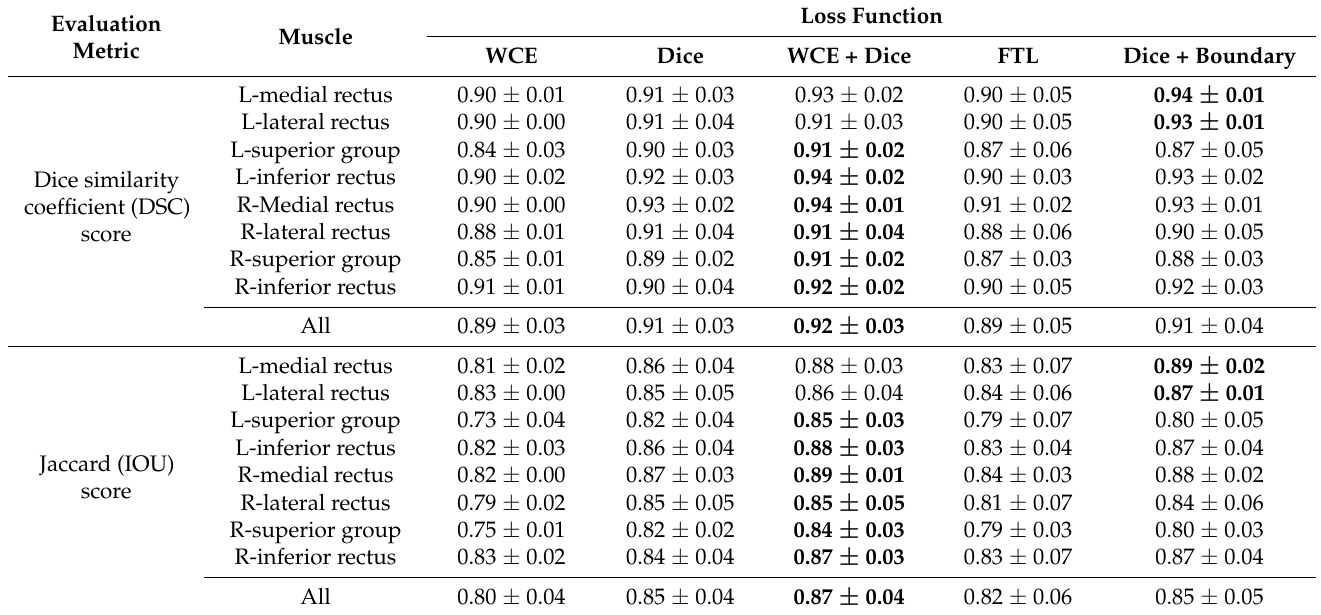
Table 2. Results from training and evaluation using 10-fold cross-validation. Values indicate mean ± standard deviation of Dice score and IOU score from 10 cross-validation iterations. Values in bold represent the loss function setting that provides the best performance for a specific muscle